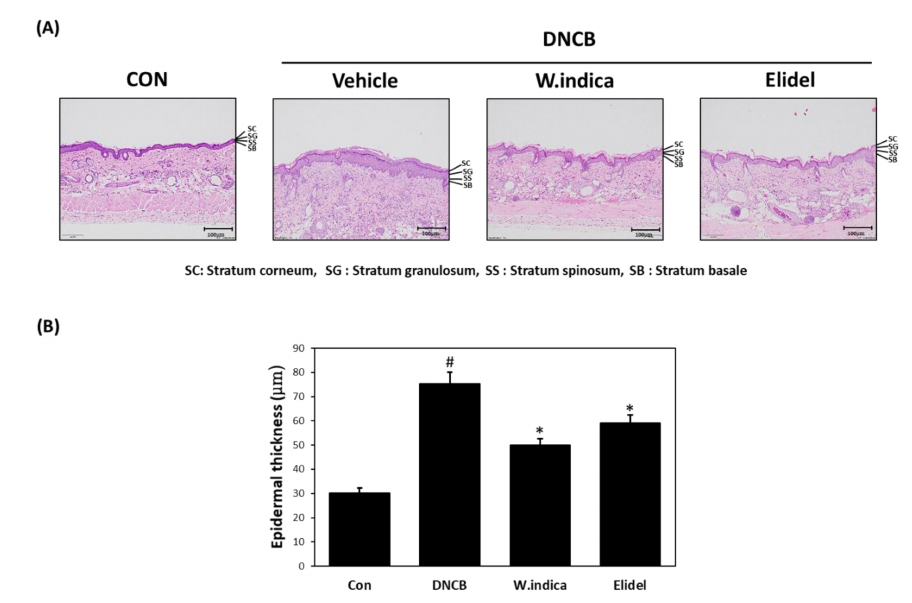
Figure 2. E ff ects of W. indica extract on hematoxylin and eosin (H & E) histopathology findings and epidermal thickness. ( A ) H & E staining result. ( B ) Epidermal thickness. Results are expressed as the means ± SEMs of two independent experiments. # p < 0.05 vs. the CON group; * p < 0.05 vs. the DNCB group. CON: vehicle control group; DNCB: DNCB + vehicle treated group; DNCB + W. indica : DNCB and 1% W. indica extract treated group; and DNCB + Elidel: DNCB and 1% pimecrolimus treated group.